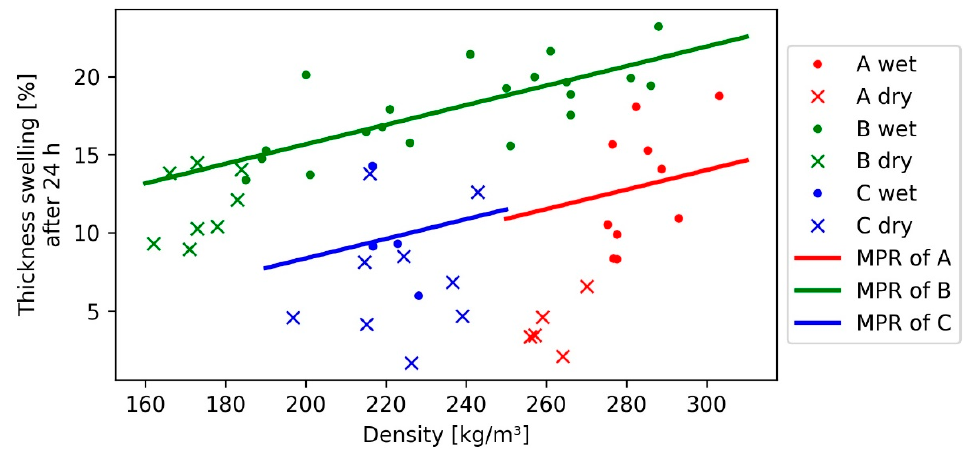
Figure 3. Multiple polynomial regression (MPR) of thickness swelling after 24 h for each bark fibre length class with the density; only the regression for wet samples is depicted.